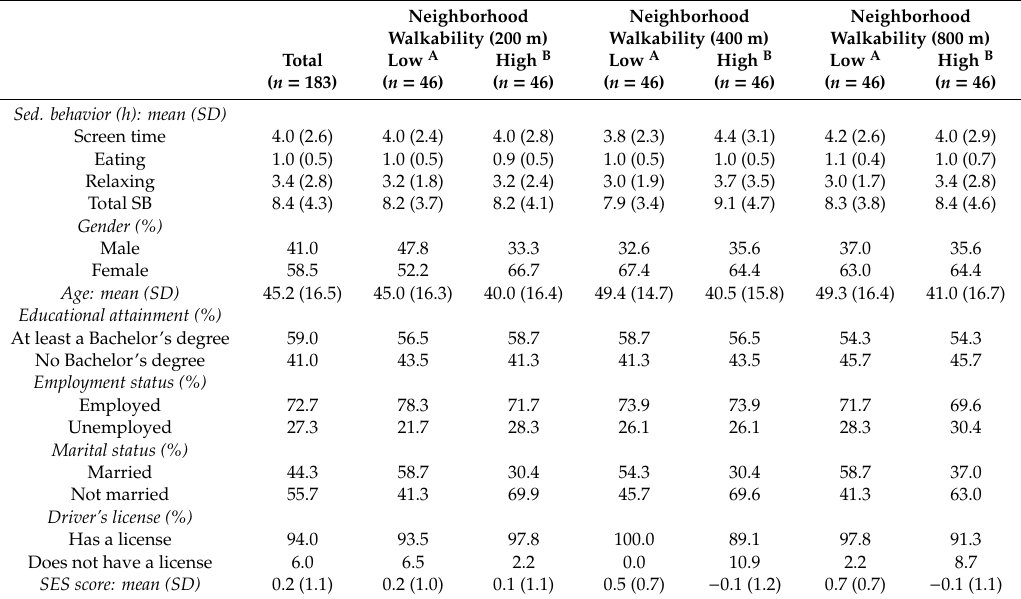
Table 2. Descriptive statistics stratified by neighborhood walkability across three bu ff er